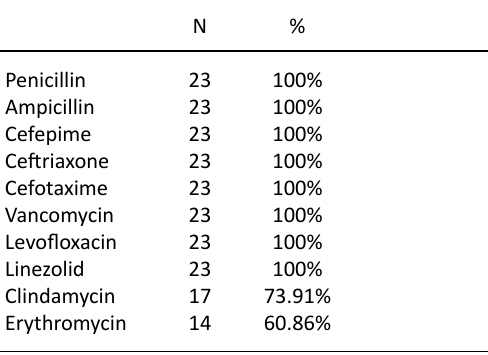
Table 5. Description of Antibiotic sensitivity for positive